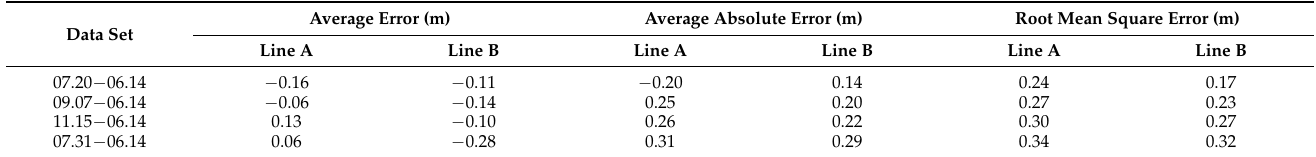
Table 4. Comparison of subsidence value error calculation between measured points and UAV extraction.